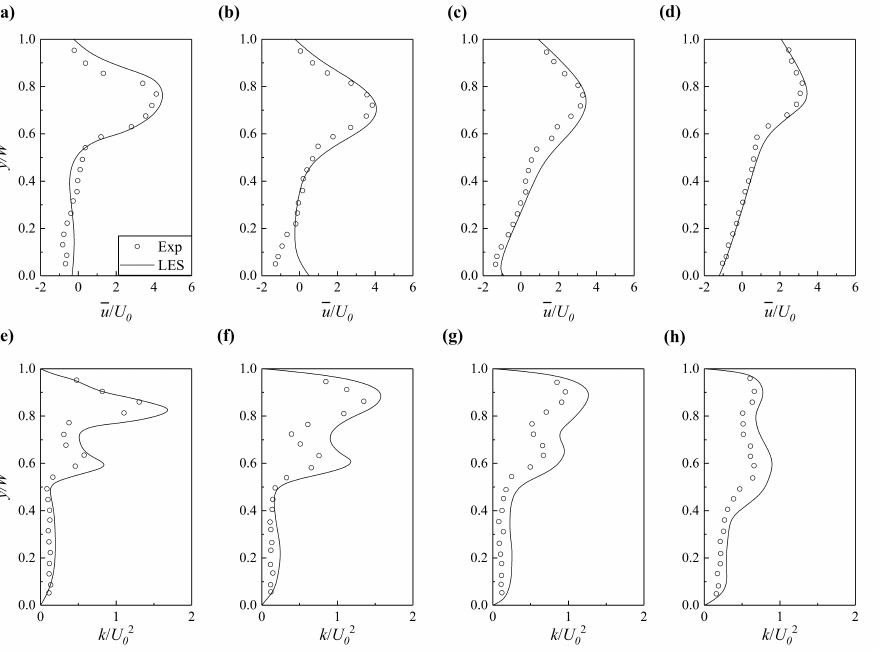
Figure 4. Measured and computed of normalized data along sampling lines: ( a – d ) normalized streamwise time-averaged velocity; ( e – h ) normalized turbulent kinetic